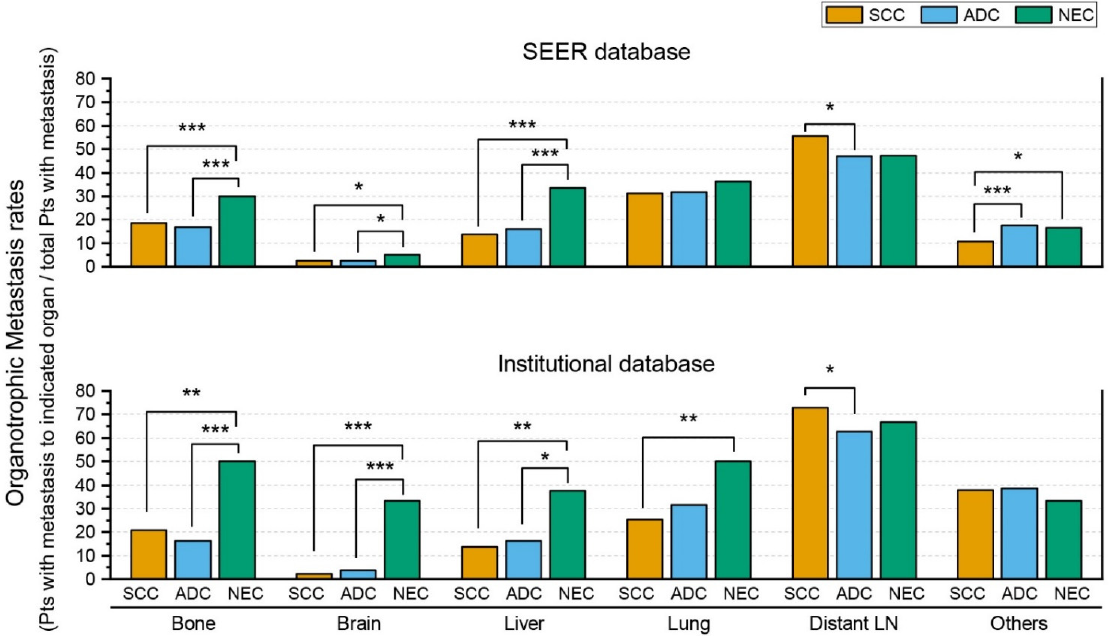
Figure 2. Comparison of organotrophic metastasis patterns of uterine cervical neuroendocrine carcinoma, squamous cell carcinoma, and adenocarcinoma between cases retrieved from the Surveillance, Epidemiology, and End Results (SEER) database and an institutional database. Only statistically significant comparisons are marked with asterisks (*, p ≤ 0.05; **, p ≤ 0.01; ***, p ≤ 0.001). (Abbreviations: SCC, squamous cell carcinoma; ADC, adenocarcinoma; NEC, neuroendocrine carcinoma; Pts, patients; LN, lymph node).